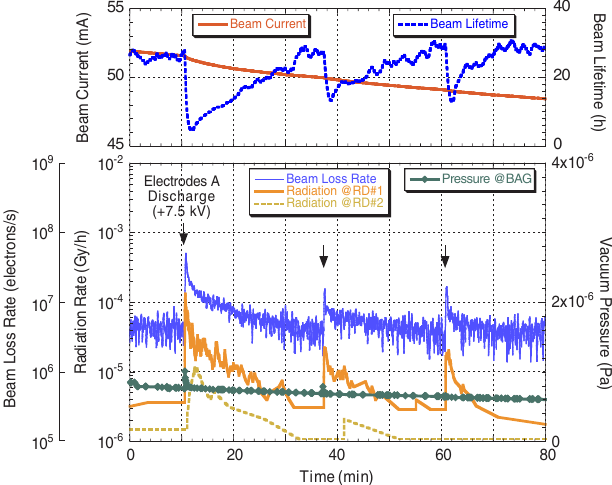
FIG. 8. (Color) Experimental data recorded when the beam life- time repeatedly decreased because of electric discharge. The discharges were artificially induced by applying DC HVs of þ 7 : 5 kV at the time indicated by the arrows.